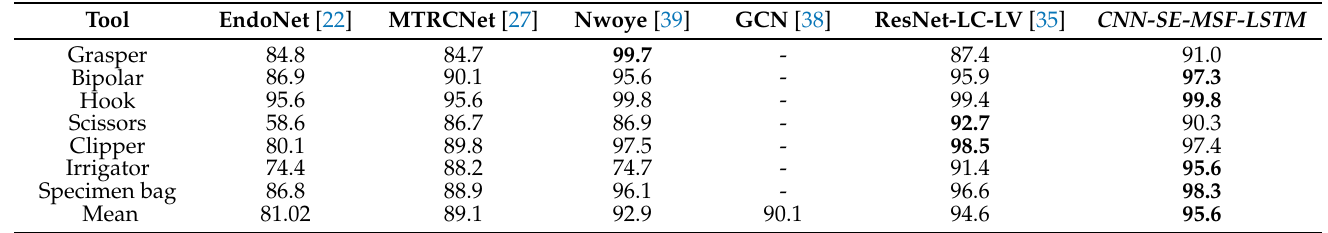
Table 3. Comparison of surgical tool presence detection results (%) of different approaches on the Cholec80 dataset (the best performances are indicated in bold).